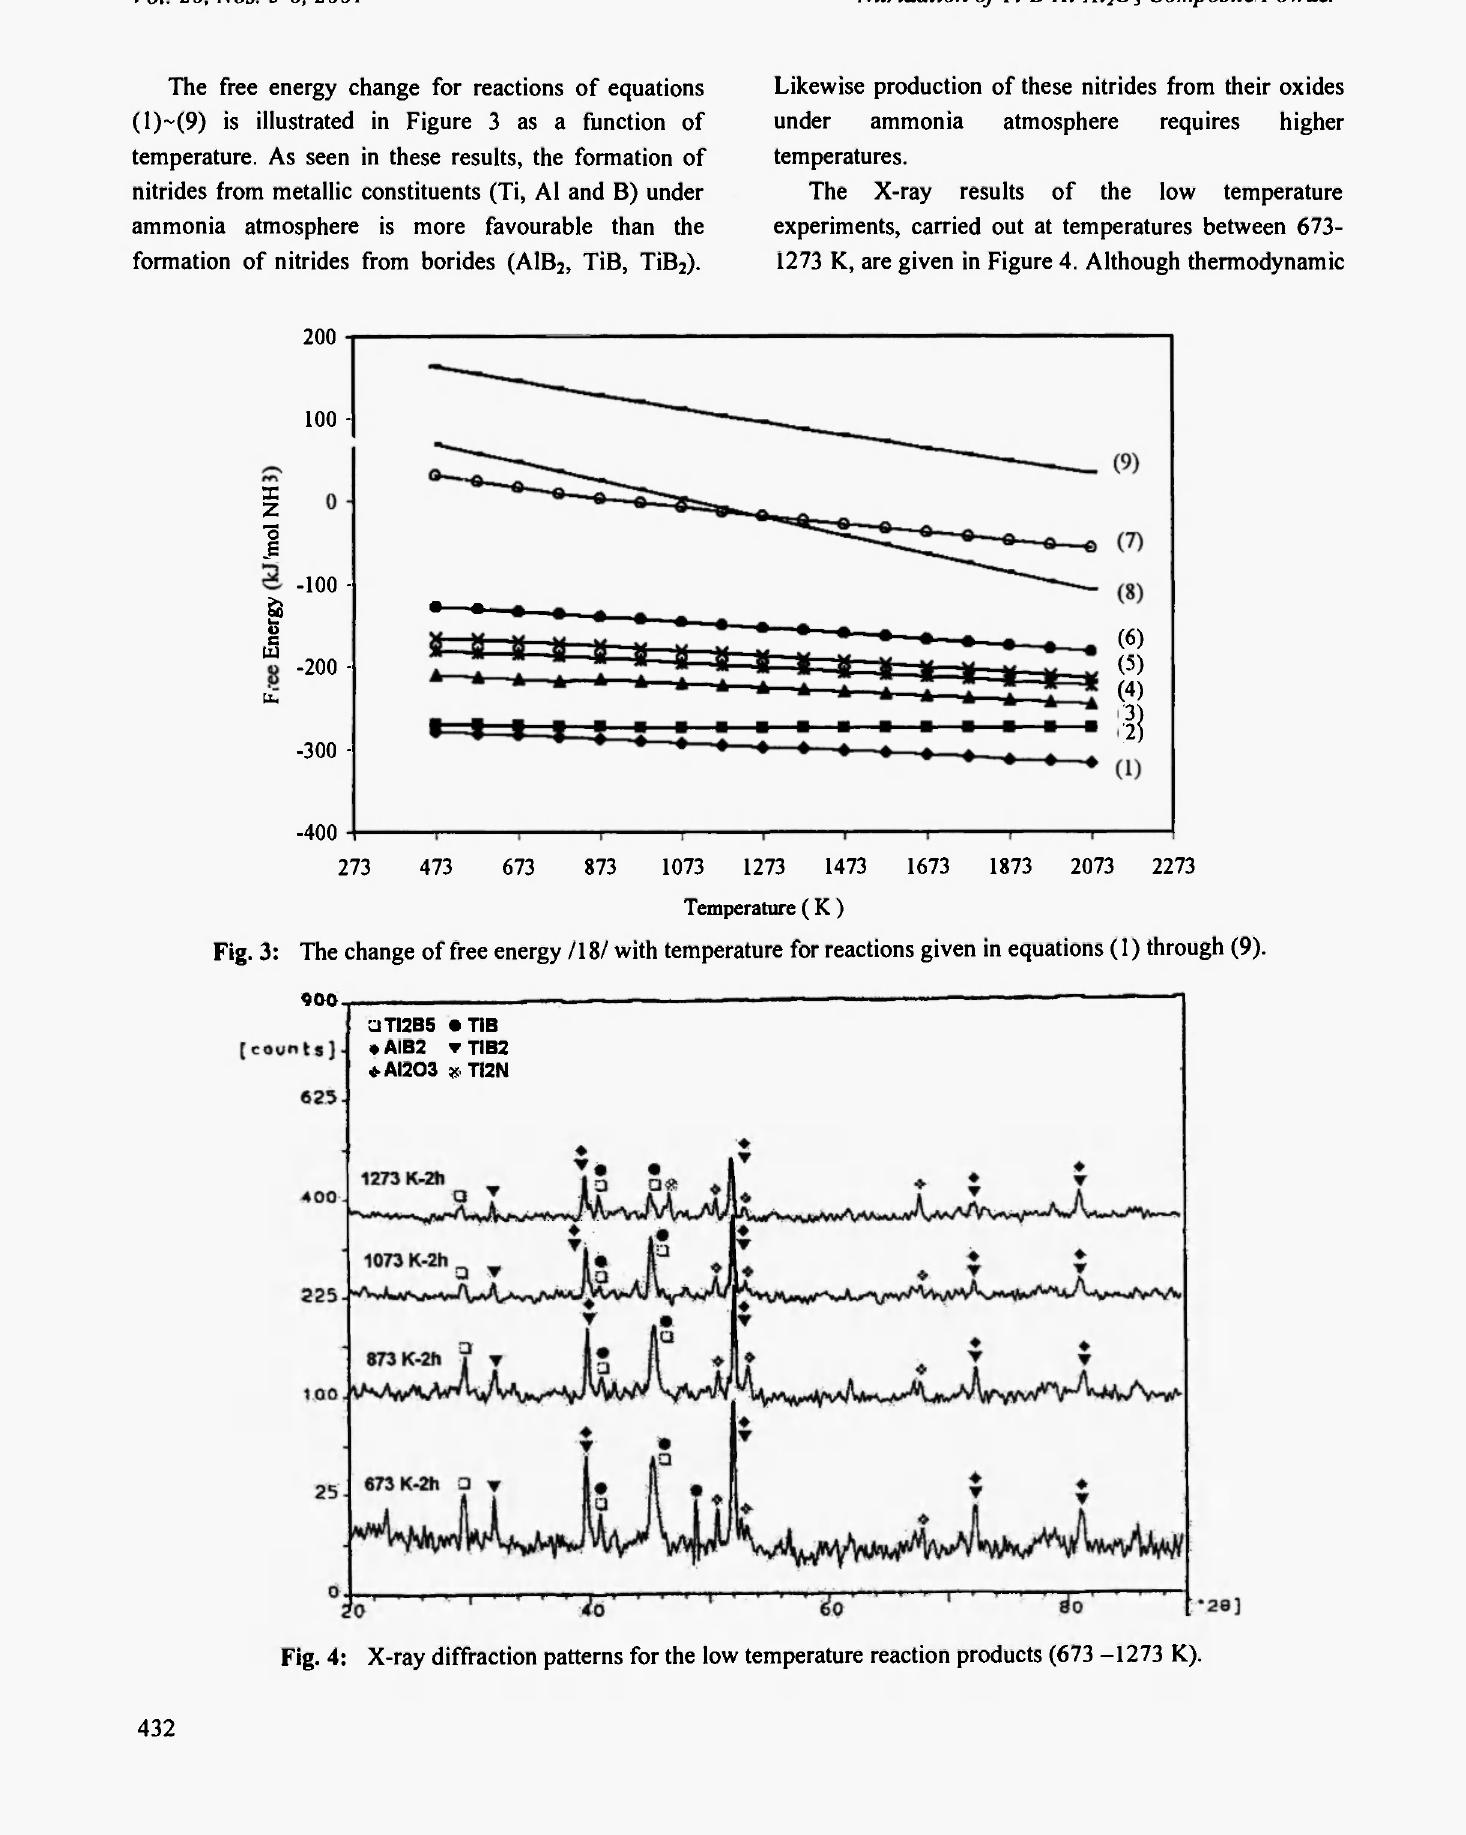
Fig. 4: X-ray diffraction patterns for the low temperature reaction products (673 -1273